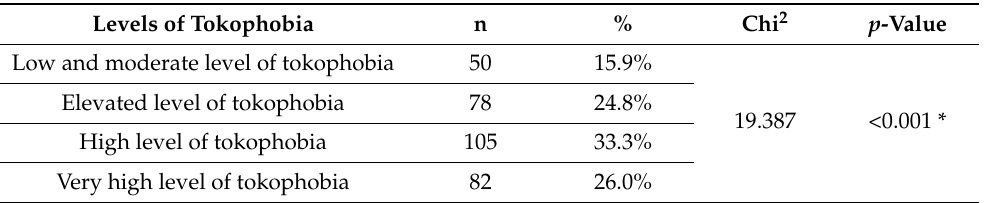
Table 3. Levels of tokophobia according to KLP questionnaire (n =